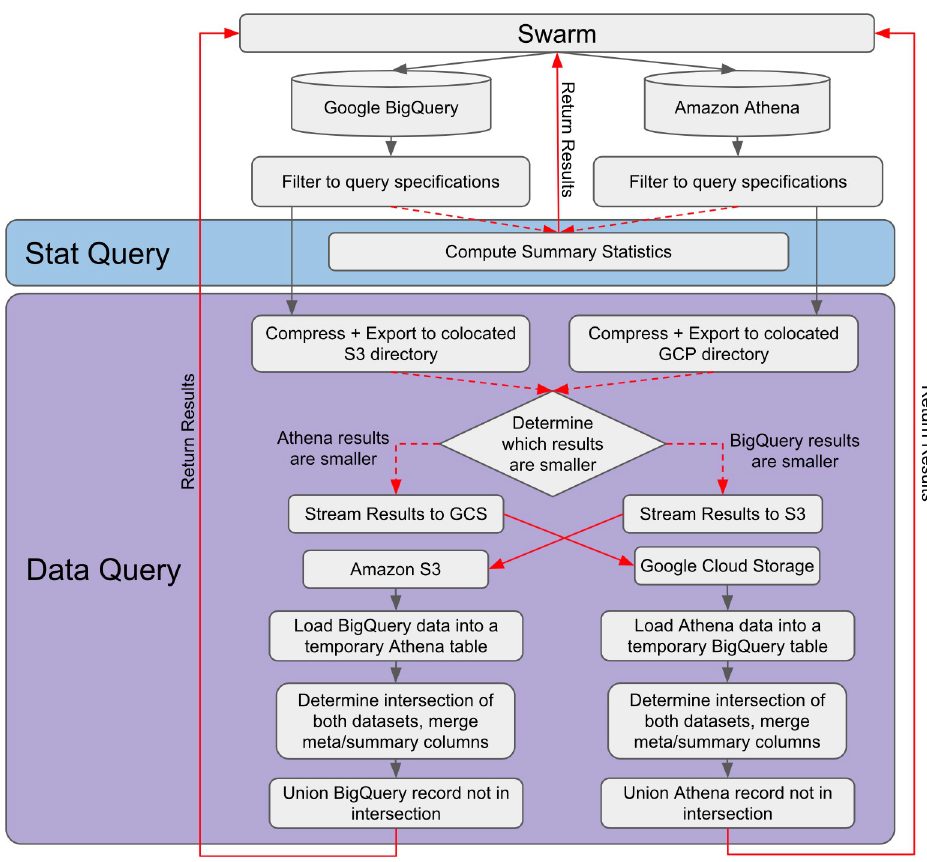
Fig 1. Swarm Framework: The Swarm architecture enables federated computation on genomic variants. It classifies variant inquiry tasks into two main categories. “Stat Query” handles all queries that do not require data motion, and returns statistics such as counts of matched records and frequency of the alleles. “Data Query” handles queries that involve moving a set of records to another computing platform for further processing. In this figure, as an example, we illustrate the use of AWS Athena and GCP